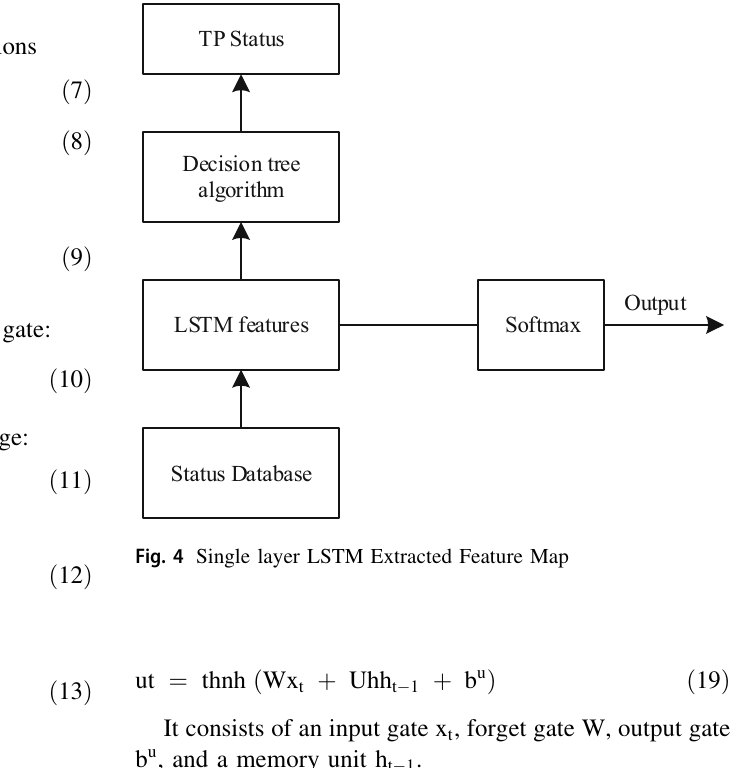
Fig. 4 Single layer LSTM Extracted Feature